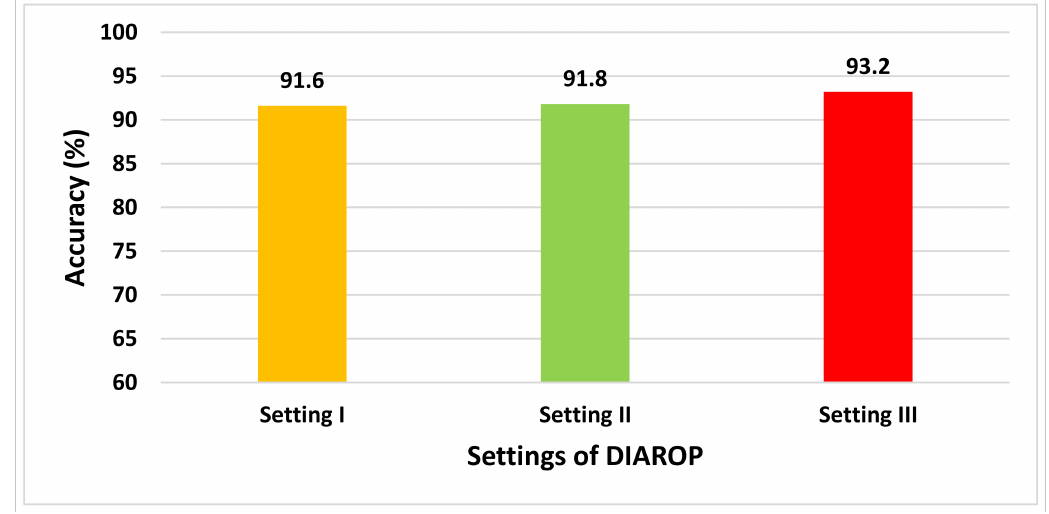
Figure 5. The accuracy (%) attained at the three settings of